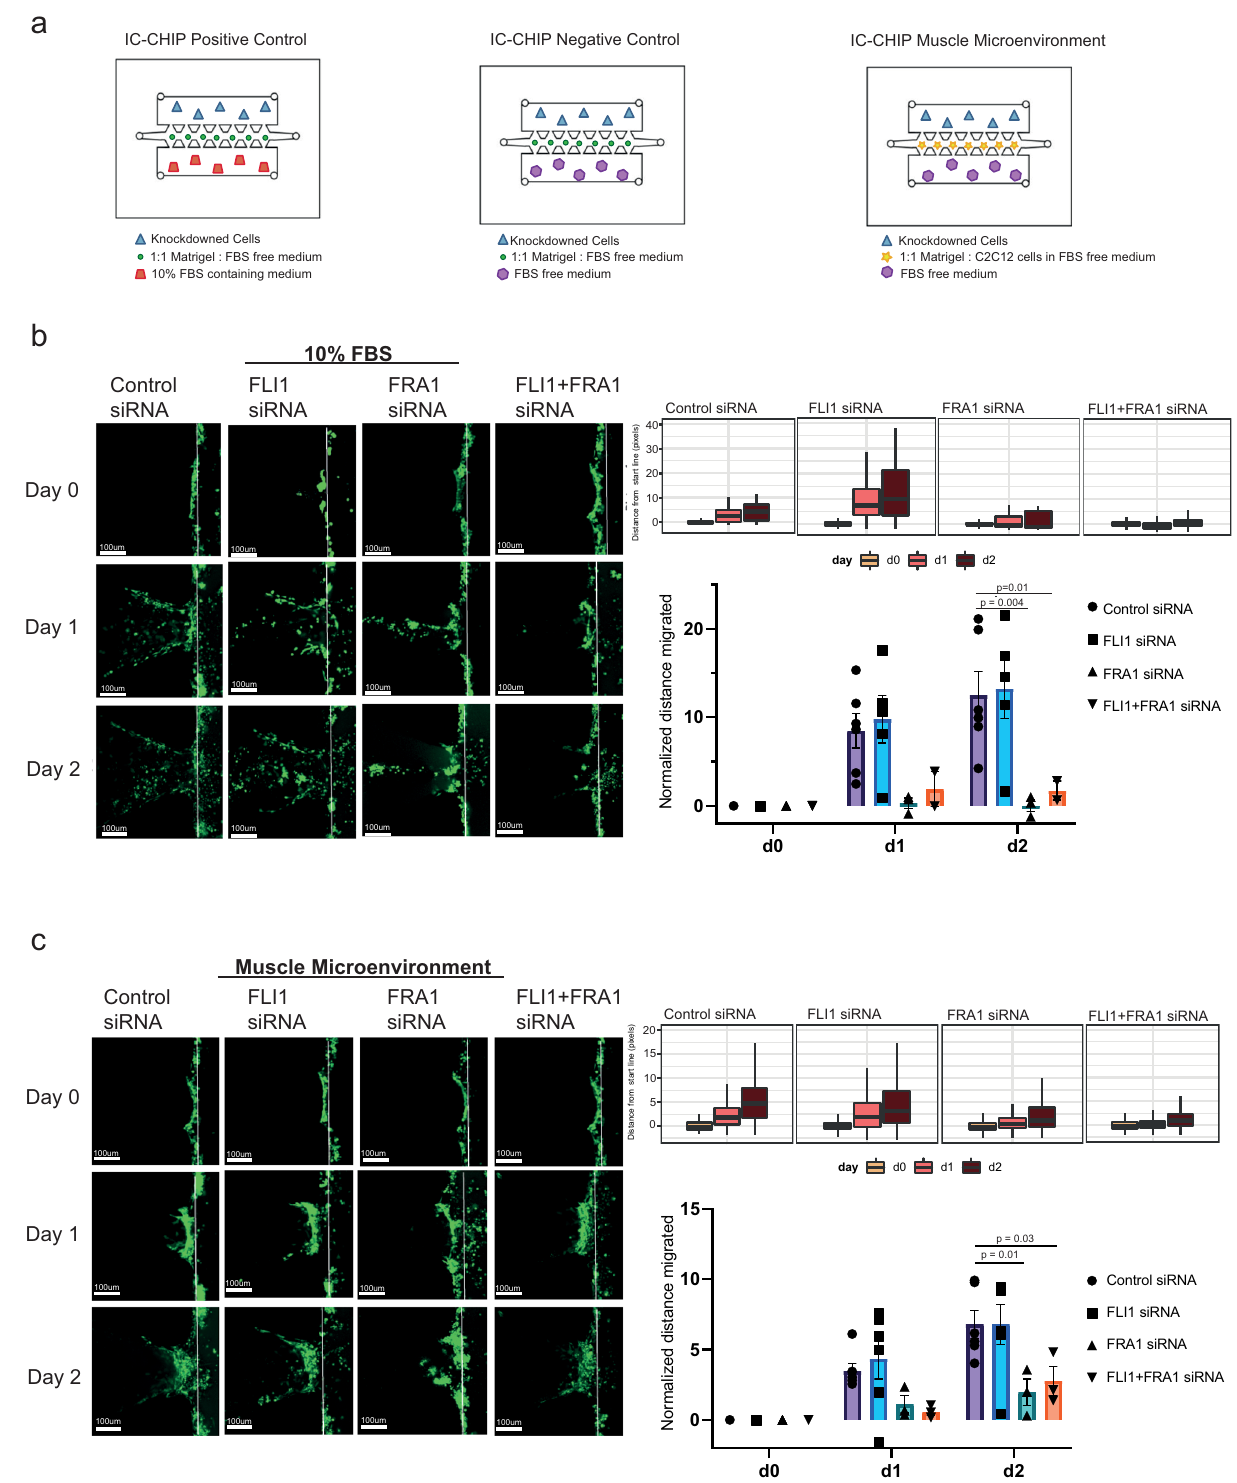
Fig. 6 FRA1 and FLI1 knockdown results in reduction of the invasion capacity in MIBC cells. a Diagram showing the experimental design using IC-CHIPs. b , c Comparison of the invasive capacity of T24 cells into cell-free matrigel in the presence of FBS ( b ) and into the muscle microenvironment ( c ). Left panels show the representative Z -stack projection images for different conditions. Scale bar: 100 µ m. Boxplots display the distribution of the distance from the start line (right upper panel). Bar graphs show the mean distance values with the SEM bars ( n = 2 – 6) from day 0 to day 2. The data is normalized to day 0 (right lower panel). Student ’ s t -test (two-tailed) was used for the